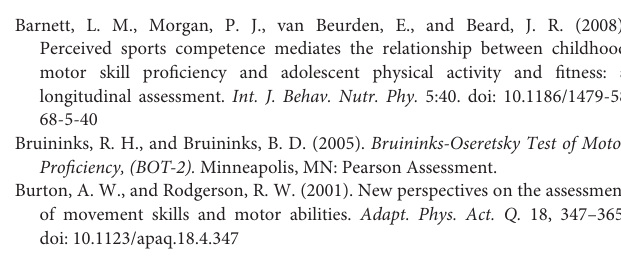
Data represent the number of children classified in a certain classification and percentage of the total. Percentage agreement between MQ3 and MQ4 is 80.8% with a Cohen’s kappa of 0.59 (p < 0.001). MQ, movement quotient; KTK-3 includes walking backwards, moving sideways and jumping sideways; KTK-3 + EHC includes walking backwards, moving sideways, jumping sideways and eye hand coordination